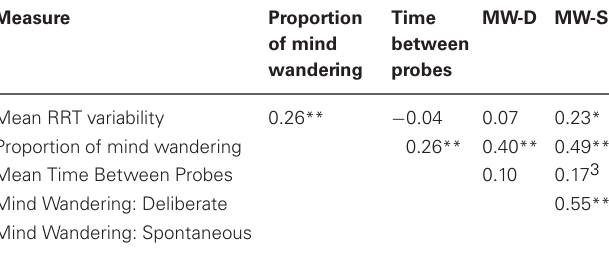
Table 2 | Pearson product-moment correlations of Mean MRT Variability, Proportion of Mind Wandering, Mean Time Between Probes, and trait mind wandering questionnaires (deliberate and spontaneous) ( N =